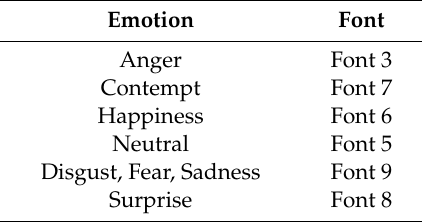
Table 2. Quantitative correspondence between fonts and emotions.